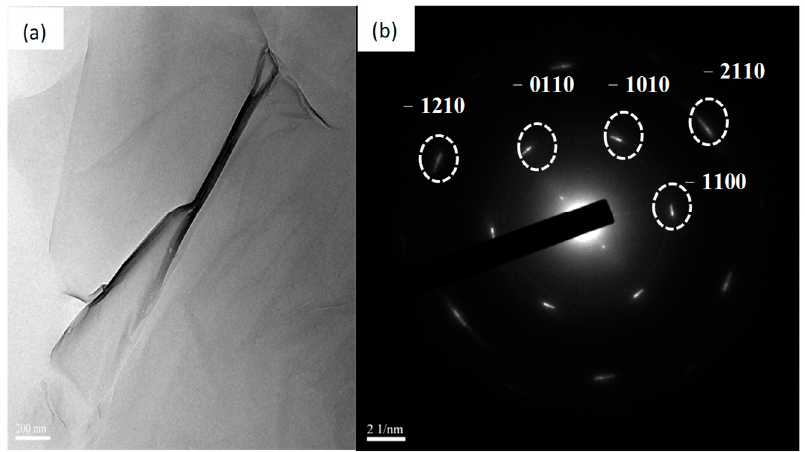
Figure 8. ( a ) TEM images and ( b ) corresponding electron diffraction pattern of graphene synthesized at optimal H 2 /Ar gas flow compositions of 15/20 sccm, temperature of 900 ◦ C, and time duration of 35 min.